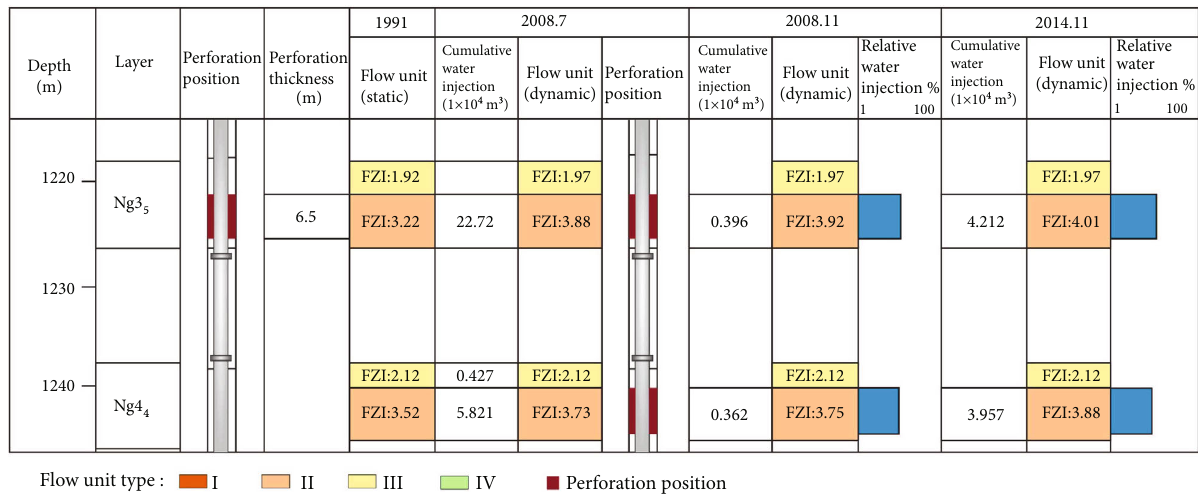
Figure 14: Test results of amplitude reducing interlayer di ff erential water absorption pro fi